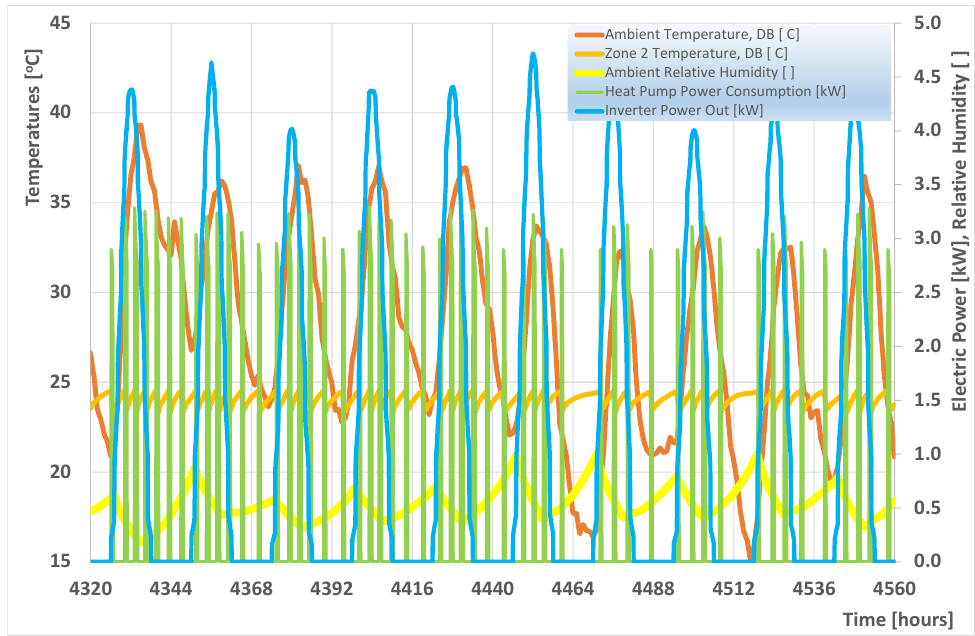
Figure 4. Transient performance of the system during the first 10 days of July. The room thermostat, which controls the heat pump operation, is set to 24 ◦ C. PV panels tilt angle is 30 ◦